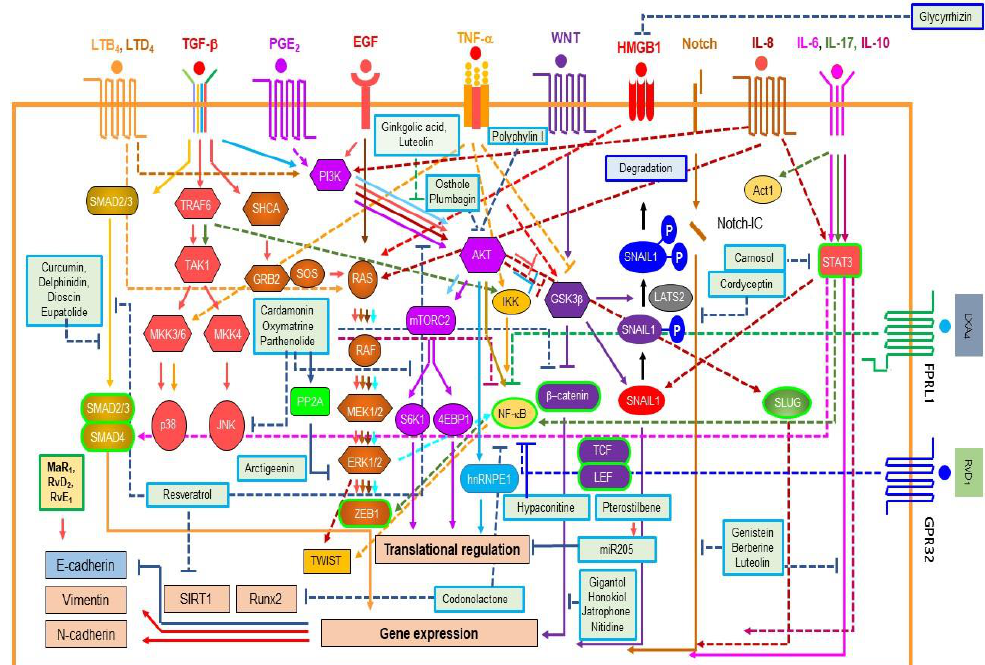
Figure 3. EMT inducers from the chronic tumor microenvironment and EMT repressors from natural anti-inflammatory compounds and pro-resolving lipids. EMT signaling process is simplified due to space limitation. Dot line (–) means indirect e ff ects. Arrow ( → ) means promotion or induction. Bar line (–I) indicates suppression. Inbox demonstrates the Lats2-mediated snail1 degradation. Receptors here have several subtypes coupled to di ff erent signaling pathway. For instance, EP4 use the PI3K / AKT pathway. This figure only covers limited parts of EMT receptor signaling. Modified from Lee’s report [6]. 4EBP1: Eukaryotic Translation Initiation Factor 4E Binding Protein 1; Act1: NF- κ B activator 1; Akt: AKR mouse thymoma; ERK: Extracellular Signal-Regulated Kinase; FPRL1: Formyl Peptide Receptor-Like 1; GSK3: Glycogen Synthase Kinase 3 Beta; GRB2: Growth Factor Receptor Bound Protein 2; hnRNPE2: Heterogeneous Nuclear Ribonucleoprotein E2; IKK: Inhibitor Of Nuclear Factor Kappa B Kinase; JNK: JUN N-Terminal Kinase; LATS2: Large Tumor Suppressor Kinase; LEF: Lymphoid Enhancer Binding Factor; MEK: MAPK / ERK Kinase; MKK: Mitogen-Activated Protein Kinase Kinase; mTORC: mammalian Target of Rapamycin Complex; NF- κ B: Nuclear Factor Kappa B; PI3K: Phosphatidylinositol-4,5-Bisphosphate 3-Kinase; PP2A: Protein Phosphatase 2A; RAF: Rapidly Accelerated Fibrosarcoma; RAS: Rat Sarcoma Viral Oncogene homolog; Runx2: RUNX Family Transcription Factor 2; S6K1: Ribosomal protein S6 kinase beta-1; SHCA: Src Homology 2 Domain Containing Adaptor protein; SIRT: Sirtuin; SMAD: Sma- and Mad-Related Protein; SOS: Son of Sevenless; STAT3: Signal Transducer And Activator of Transcription 3; TAK1: TGF- Activated Kinase 1; TCF: Transcription Factor; TRAF6: TNF Receptor Associated Factor 6; TWIST: Twist Family BHLH Transcription Factor; ZEB1: Zinc Finger E-Box Binding Homeobox